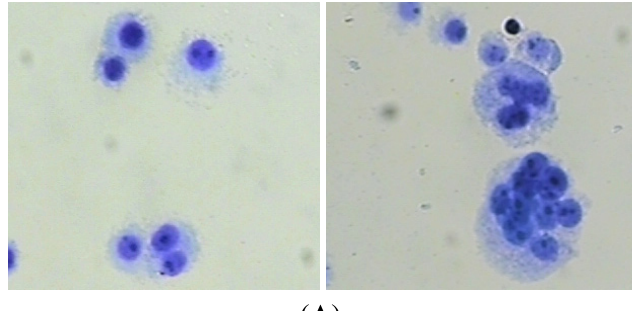
Figure 4. Compounds induced megakaryopoiesis in HEL cells. ( A ) Light microscopy shows that the image of megakarycytes (control and compound 1 , left and right respectively) stained by Giemsa; ( B ) The percentage of megakaryocytes was determined on the basis of the number of endomitosis. Results are representative of at least three independent experiments run in triplicate and expressed as the mean ±